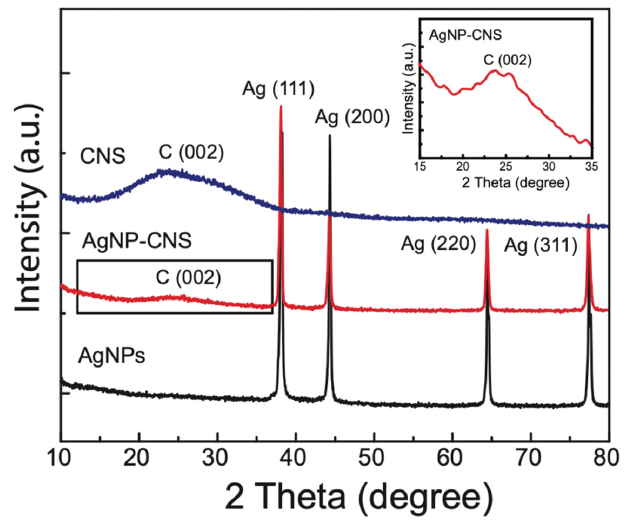
Figure 3. XRD patterns of the AgNPs, CNSs, and the AgNP–CNS nanocomposite.